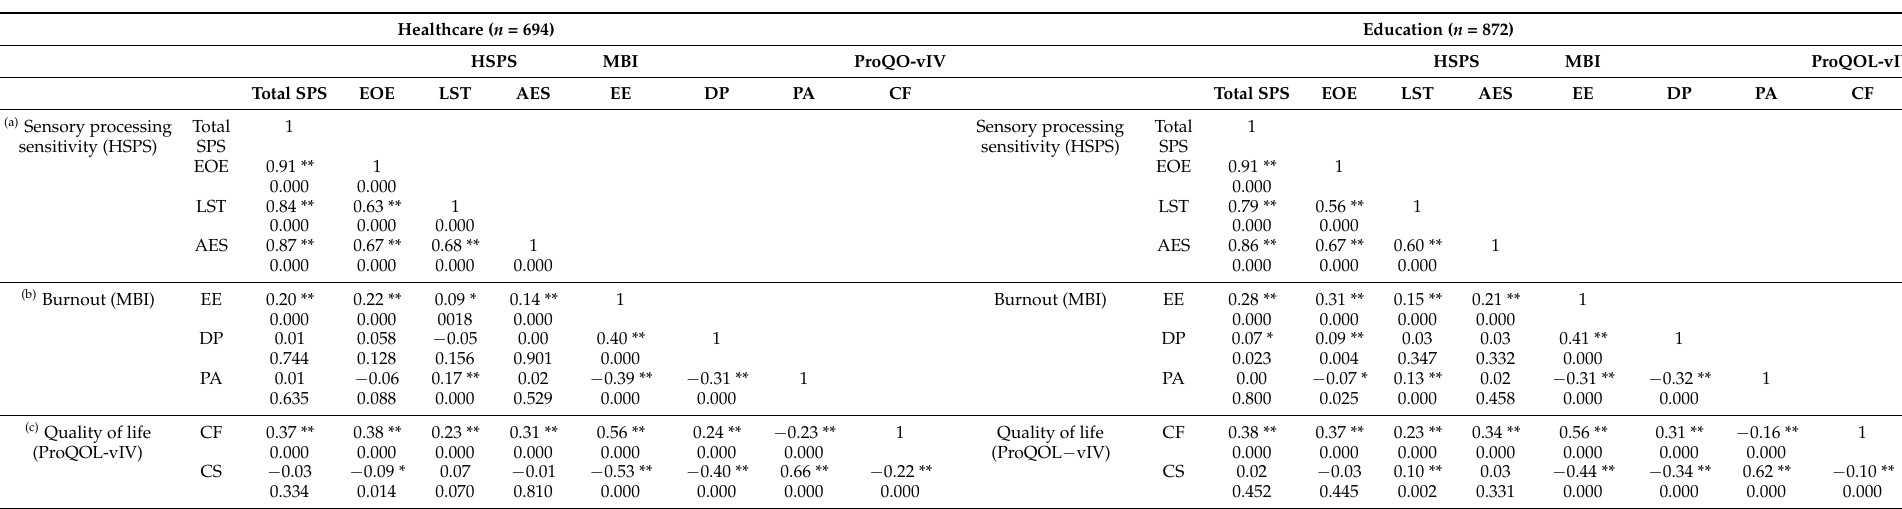
Table 3. Relationship between healthcare and education